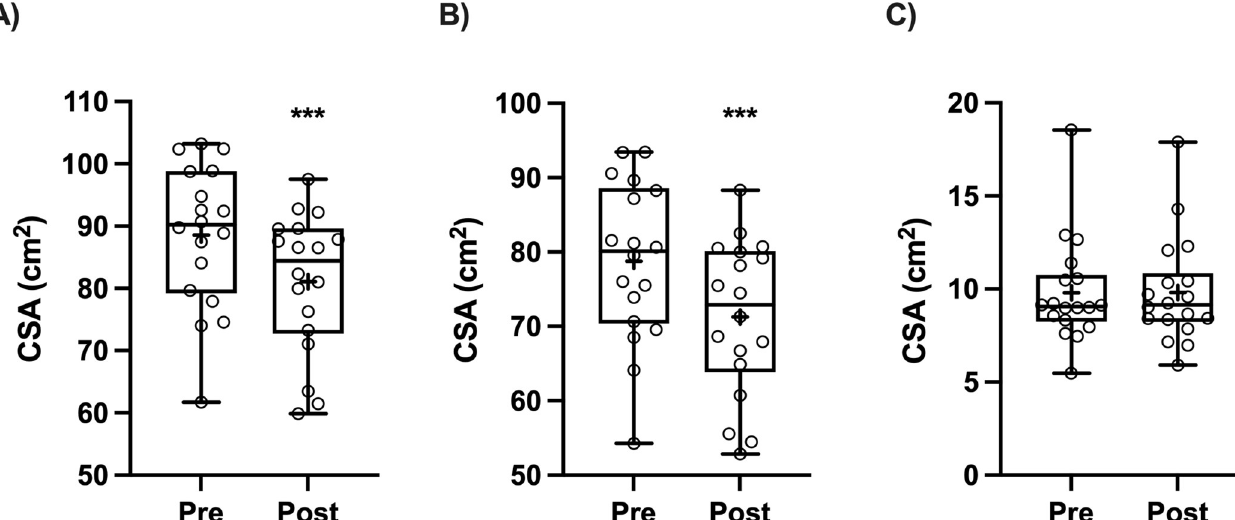
Fig 3. Pre-immobilization and post-immobilization (14 d) cross sectional area (cm 2 ) of immobilized limb (A) quadriceps femoris , (B) vastus group , and (C) rectus femoris assessed by MRI (n = 18). Data were analysed using paired t-tests and Wilcoxon matched-pairs test (rectus femoris). ��� P < 0.001 compared to Pre-immobilization. + represents mean. Box contains the median (line) and shows the 25th to 75th percentile, and whiskers represent minimum and maximum values.